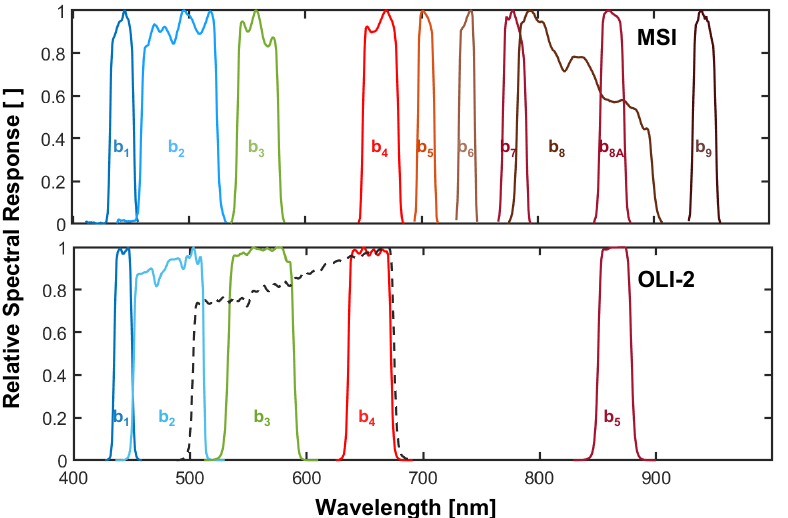
Figure 4. Relative spectral response of OLI-2 and MSI onboard Landsat-9 and Sentinel-2, respec- tively. The band numbers are provided for each sensor, and the gray dashed line shows Landsat-9 panchromatic band.